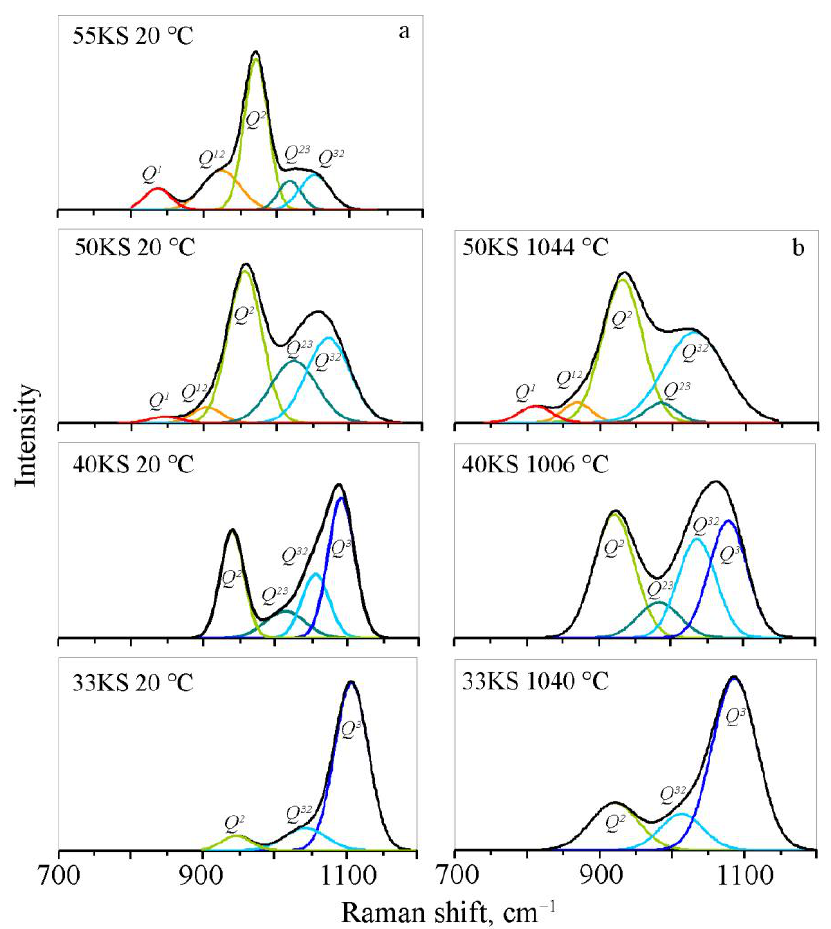
Figure 3. Decomposition and interpretation of Raman spectra of K 2 O-SiO 2 glasses ( a ) and melts ( b ).